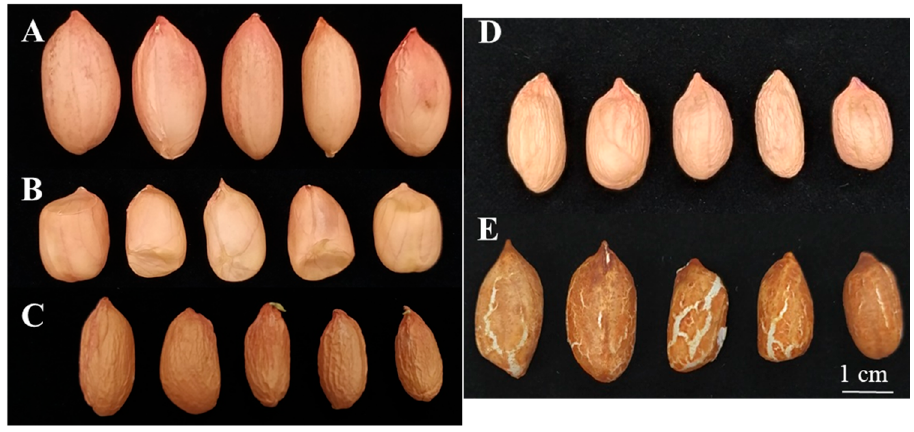
Figure 8. Seeds of mutants and their corresponding control. ( A ) The control HY22; ( B , C ) Mutants of HY22; ( D ) The control YY45; ( E ) Mutants of YY45.